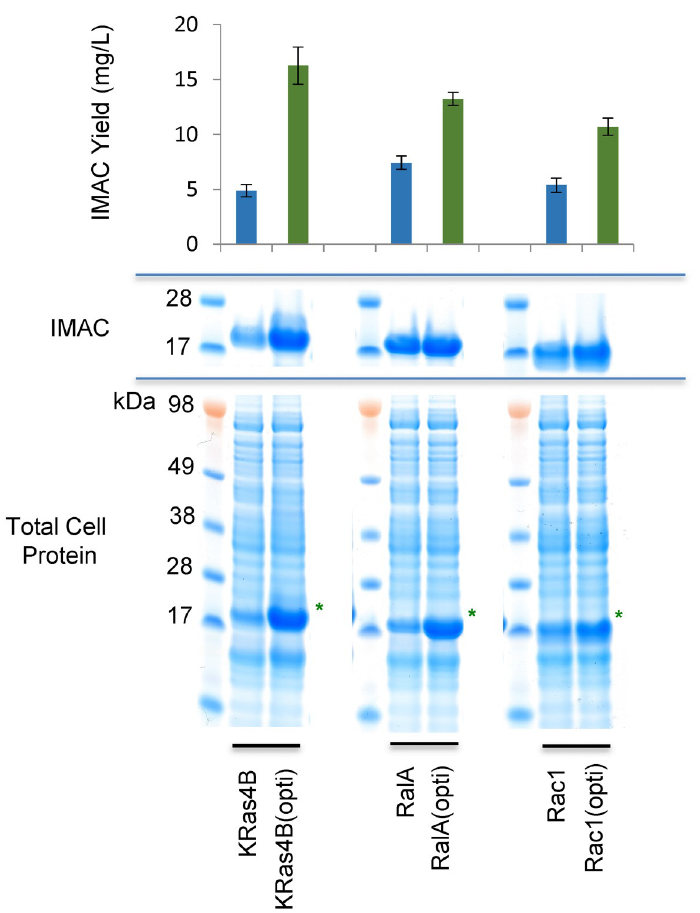
Fig 1. Comparison of yields from native and codon optimized sequences. SDS-PAGE analysis and quantification of soluble fraction IMAC yield for GTPase expression clones containing the Homo sapiens non-optimized sequence cDNA or a fully codon optimised version. The position of the target GTPase is indicated by a green asterisk. All IMAC purifications were performed as n = 3 technical replicates, deriving from distinct replicate 1L cultures.